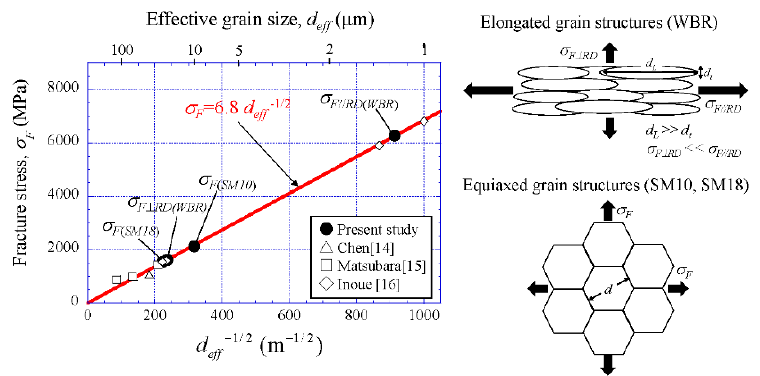
Figure 13. Fracture stress vs. effective grain size.